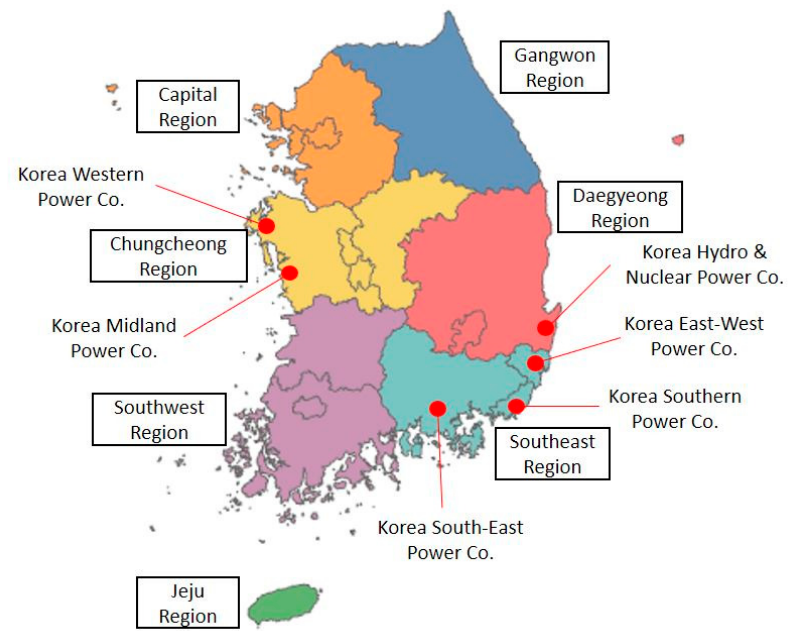
Figure 2. Six Electric Power Companies in South Korea. Note: (a) Different colors represent each region that consists of a few provinces and metropolitan cities and plays as an economic bloc in South Korea. For instance, the Southeast Region, as an independent economic bloc, is composed of a province (i.e., Gyeongsangnam-do) and two metropolitan cities (i.e., Busan and Ulsan). (b) Each red dot represents the locations of each electric power company ′ s headquarters. While their power plants are spread along the coastline, their headquarters tend to concentrate in the Southeast and Chungcheong Regions, partly because they are geographically close to big ports that provide easy access to imported energy (e.g., coal, gas, and oil). Source: Created by authors.